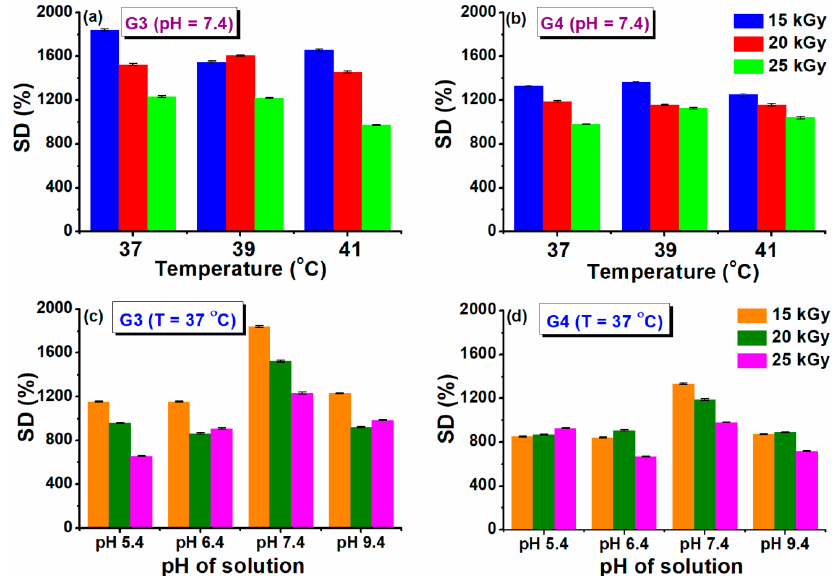
Figure 2. Swelling degree at di ff erent temperatures ( a , b ) and pH solutions ( c , d